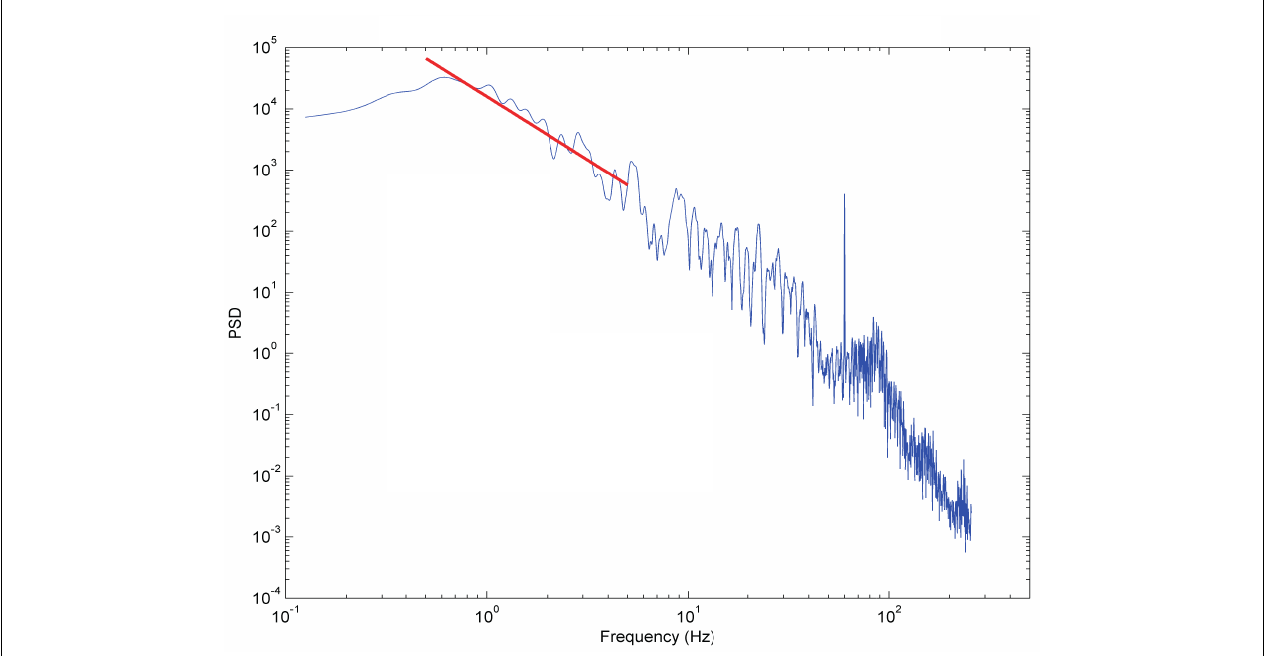
FIGURE 3 |Typical PSD plot from subject 3 in SWS from a single 30s time interval. Y axis is log power. X axis is log frequency. Red line indicates segment two slope fit (slope =−